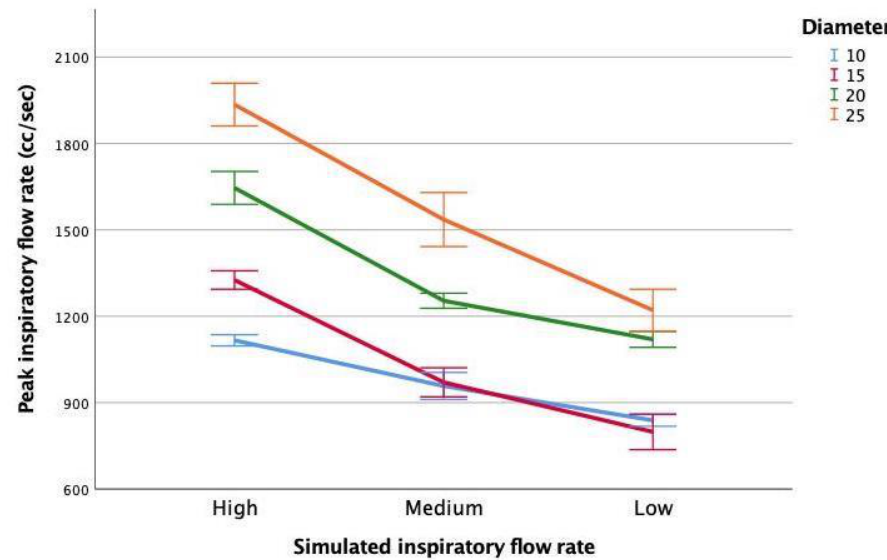
Figure 4. PIFr measured by pneumotachometer for syringe generated. Inspiratory flows by flow rate and mouth diameter.